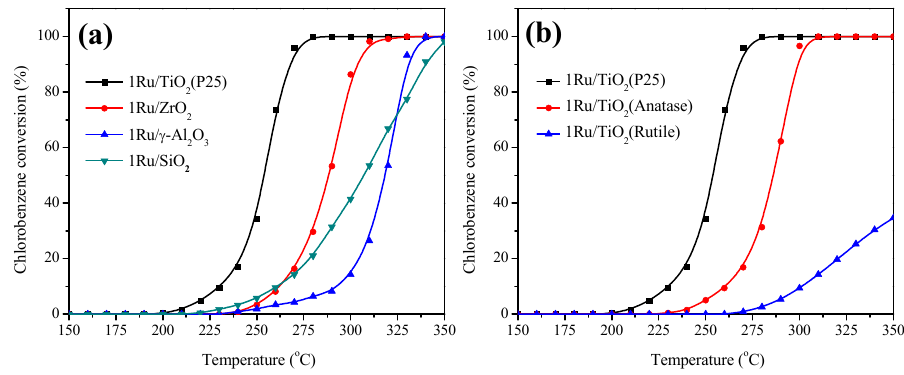
Figure 1. Chlorobenzene conversion as a function of reaction temperature over ( a ) 1Ru/TiO 2 (P25), 1Ru/ZrO 2 , 1Ru/ γ‐ Al 2 O 3 , and 1Ru/SiO 2 , and ( b ) 1Ru/TiO 2 (P25), 1Ru/TiO 2 (Anatase), and 1Ru/TiO 2 (Rutile) under the conditions of chlorobenzene concentration = 500 ppm, chlorobenzene/O 2 molar ratio = 1/400, and weight hourly space velocity (WHSV) = 60,000 mL/(g h).